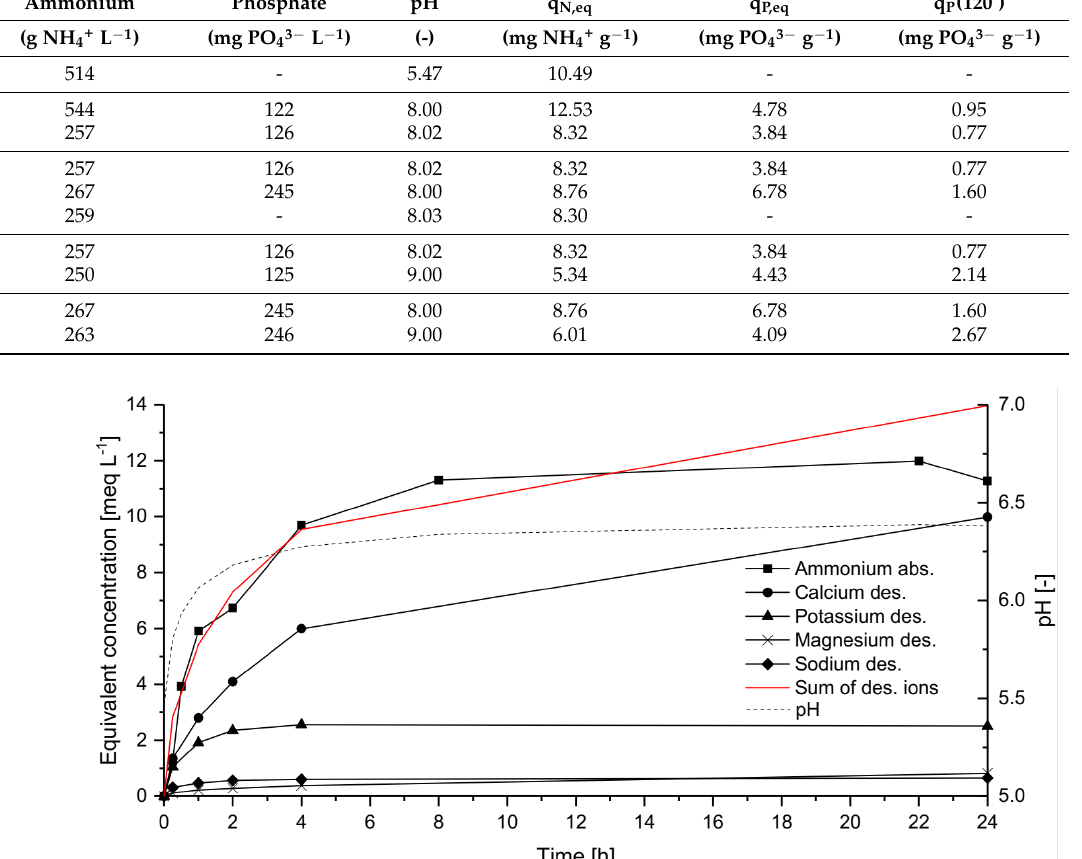
Table 1. Overview of initial parameters and zeolite loading at equilibrium and after 120 min. Initial Parameters Zeolite Loading